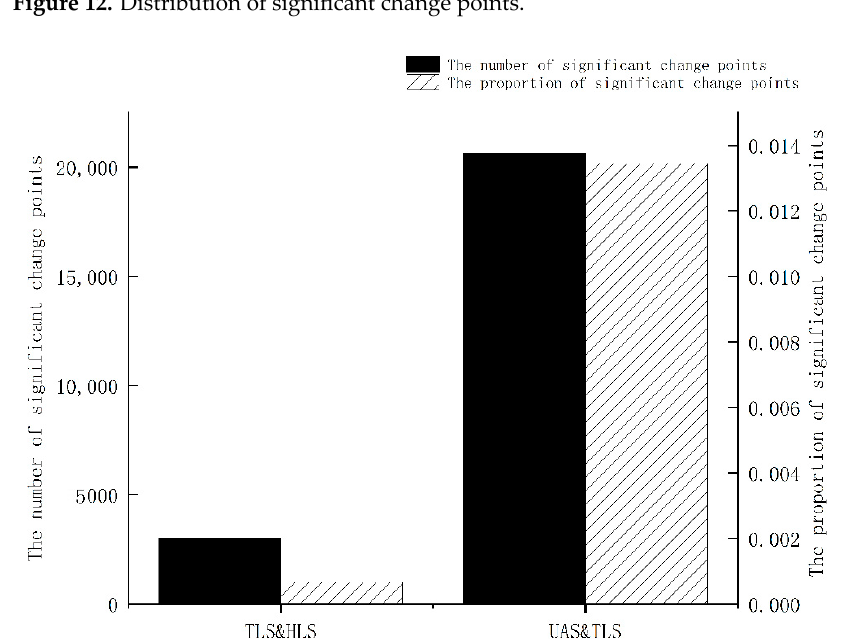
Figure 12. Distribution of significant change points.